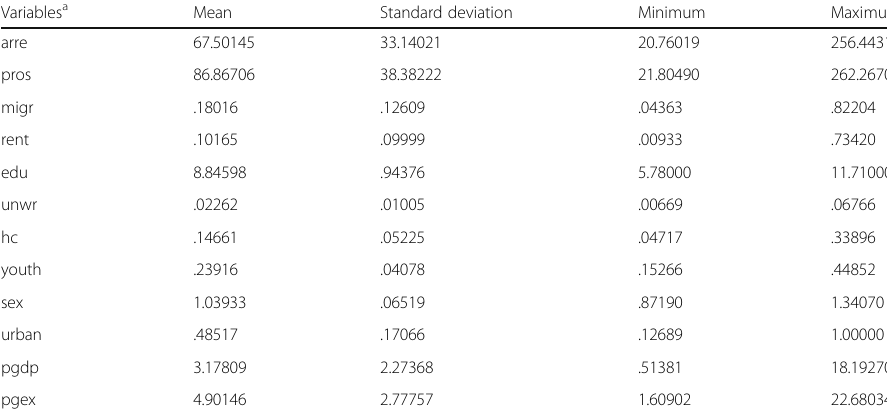
Table 2 Descriptive statistics of variables n =